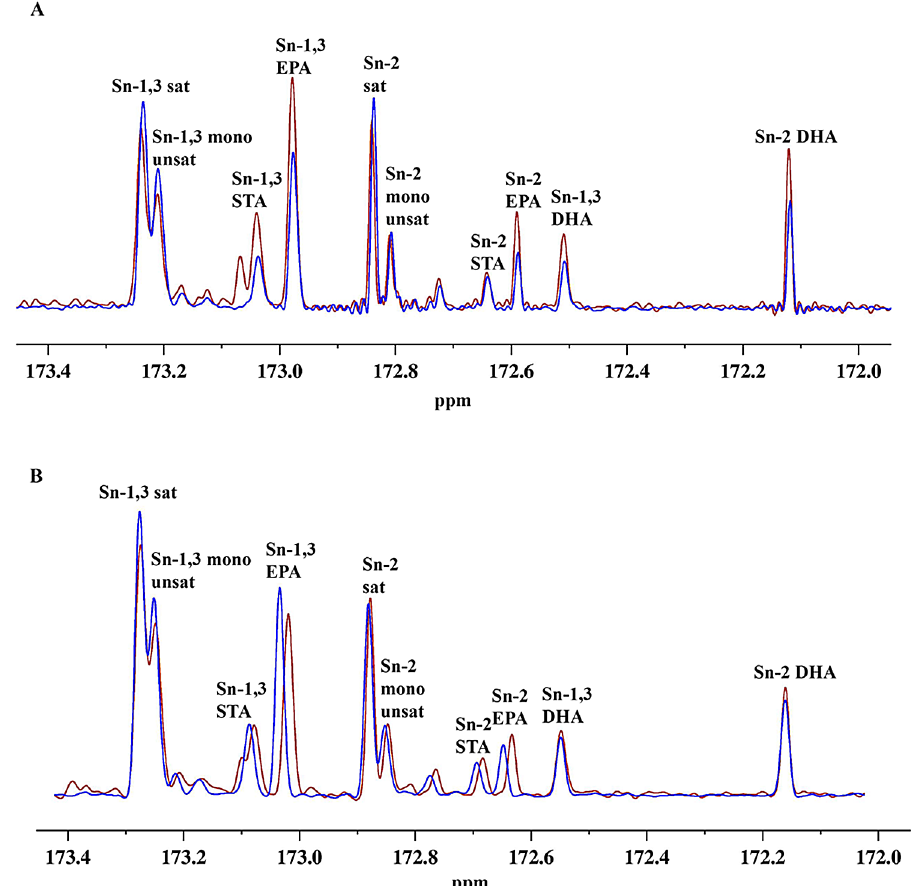
(saturated), mono (monounsaturated), STA (stearidonic acid), EPA (eicosapentaenoic acid) and DHA (docosahexaenoic